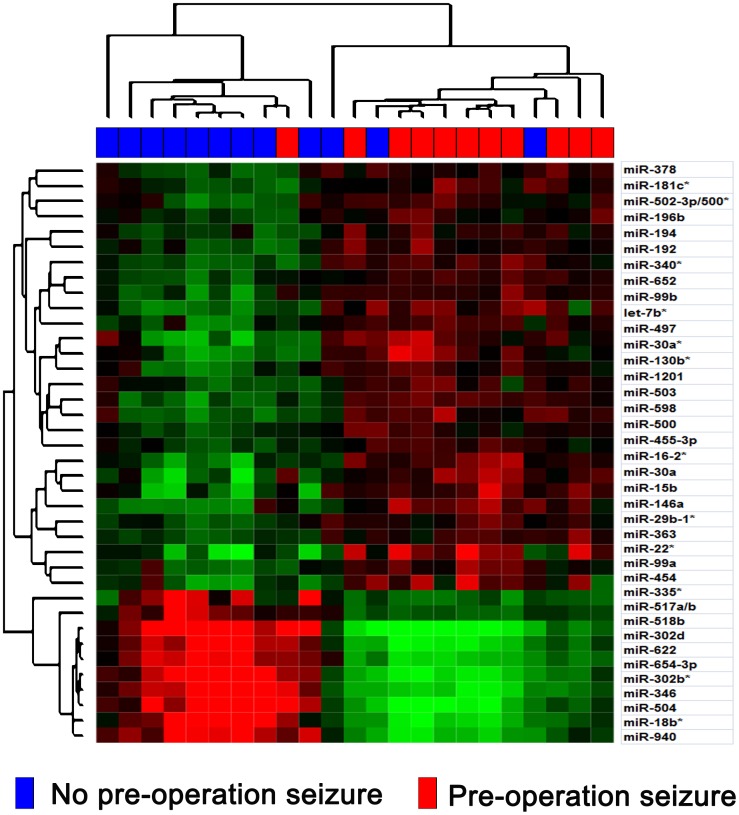
Heat map of the differentially expressed genes identified using SAM analysis (Q value <1%) showing 30 overexpressed and 10 underexpressed miRNAs in seizure group.